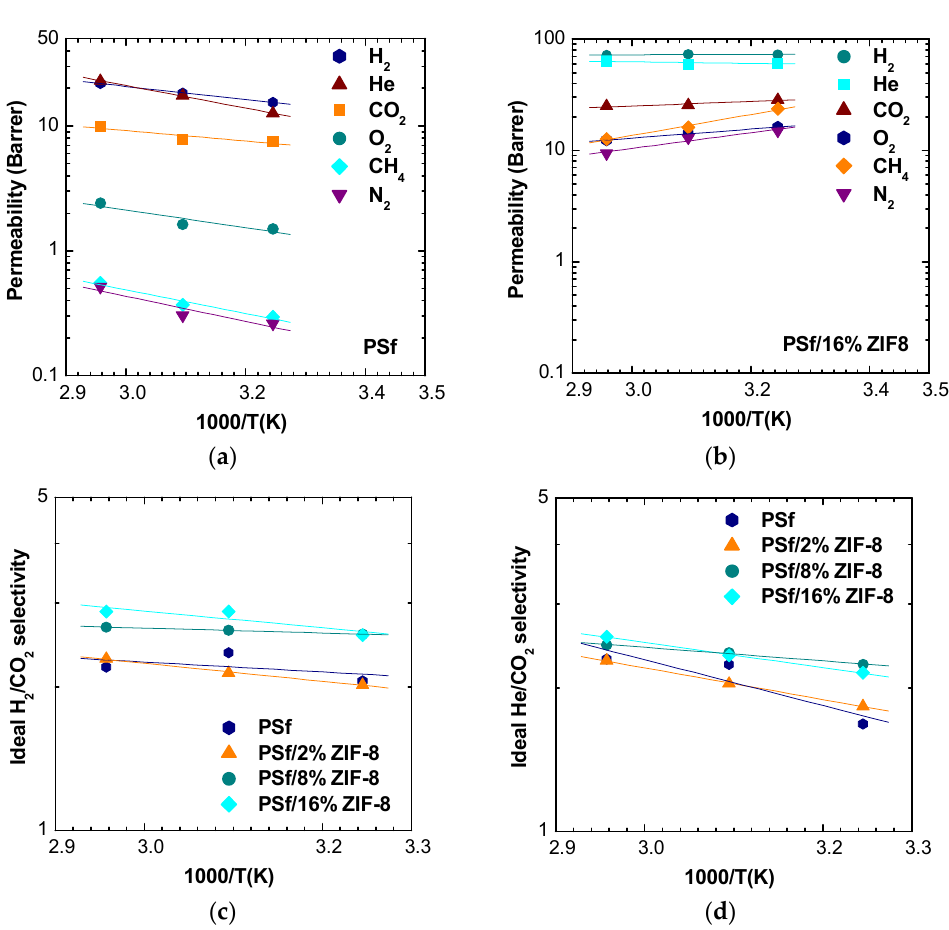
Figure 7. Permeability and selectivity in PSf/ZIF-8 mixed matrix membranes as a function of 1000/T: ( a ) Permeability in PSf; ( b ) Permeability in PSf/16% ZIF-8; ( c ) H 2 /CO 2 selectivity; and ( d ) He/CO 2 selectivity in all the MMMs inspected.